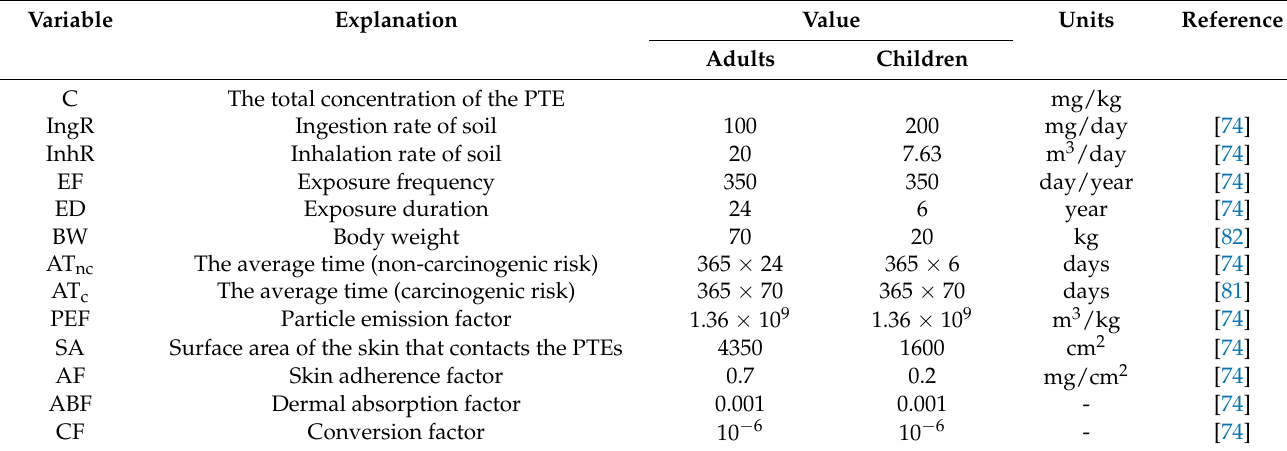
Table 1. Exposure factors for human health risk